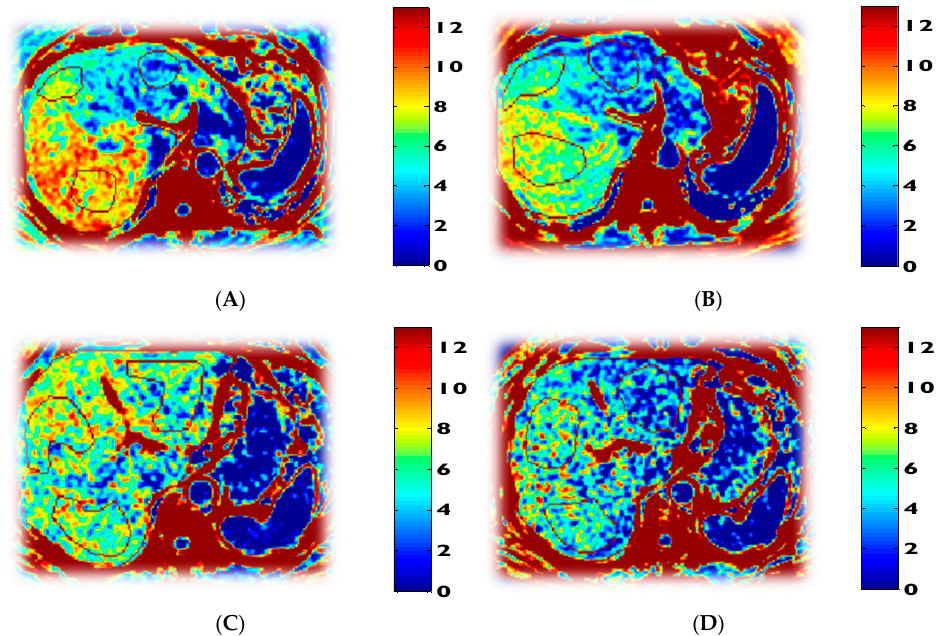
Figure 7. Effect of supplementing GlyNAC on liver magnetic resonance spectroscopy (MRS) in 2 participants with non-alcoholic fatty-liver disease (NAFLD). The panels show liver MRS data of % fat-fraction in 2 participants done before and 12 w after receiving GlyNAC supplementation: ( A ) participant 1 before GlyNAC supplementation; ( B ) participant 1 after GlyNAC supplementation; ( C ) participant 2 before GlyNAC supplementation; ( D ) participant 2 after GlyNAC supplementation.